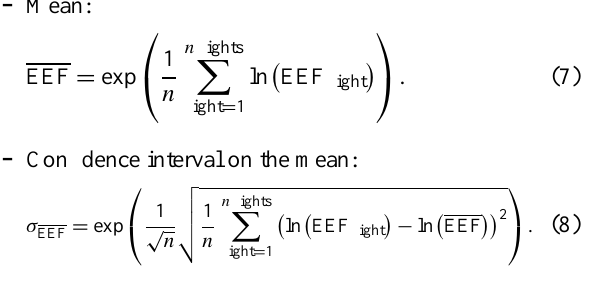
Figure 7. BC (top panel) and NO x (bottom panel) emission error factors (EEFs) for each individual flight (when available) and aver- aged EEF (on the right) at the 95% confidence interval, for all six simulated cases (logarithmic